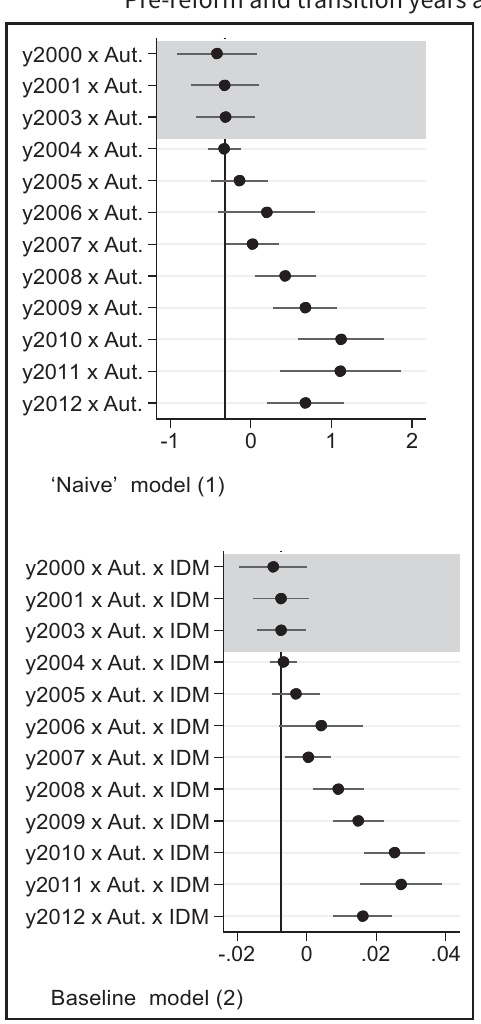
Leads and lags. Notes: The figure plots interactions between autonomy and year dummies (“naive model”) and three-way interactions between autonomy, local development, and year dummies (baseline model); point estimates represent differences with respect to 2002. Spikes represent 95% confidence intervals. Pre-reform and transition years are shaded in